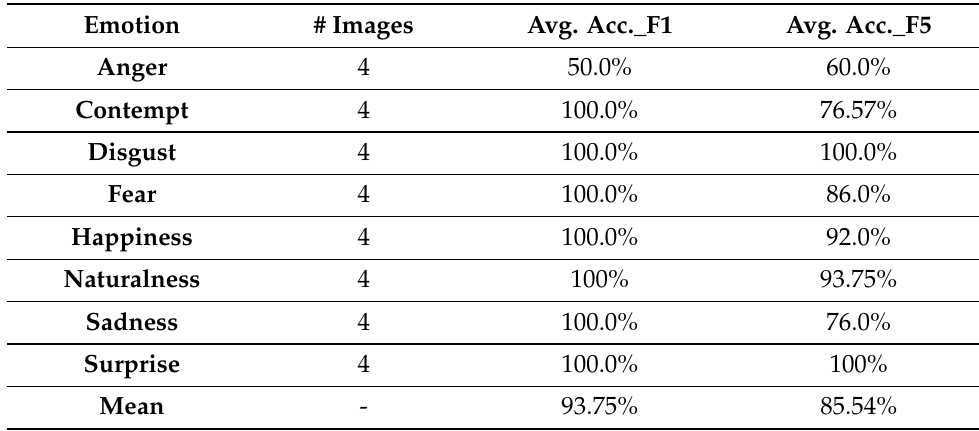
Table 4. Performance per class and average accuracy using both models, achieved with one-fold and five-fold cross-validation, on test set from TFEID